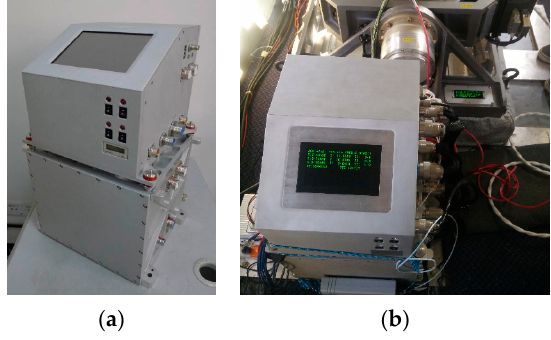
Table 1. Properties of SGA-WZ02.